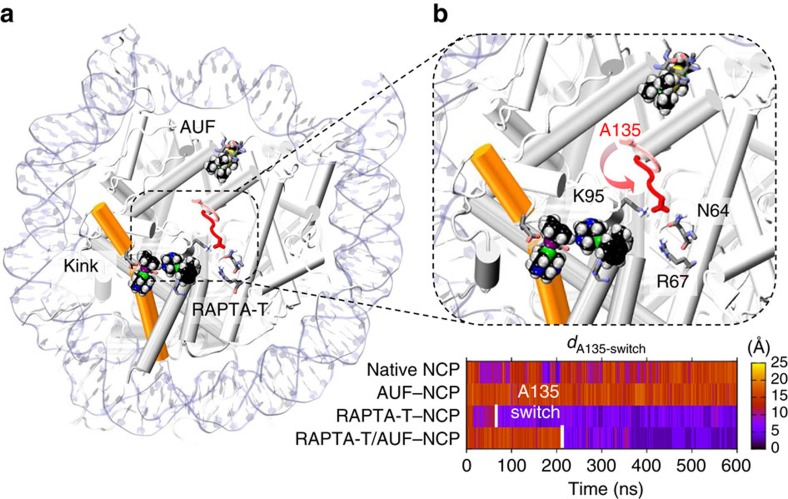
Conformational changes induced by RAPTA-T adducts.(a) Snapshot from MD simulations of the RAPTA-T/AUF–NCP system, showing a kink within the long α-helix of H2A induced by the presence of RAPTA-T adducts. The histone proteins (grey) are shown as cartoon, highlighting the kinked H2A α-helix in orange. The DNA is represented as pale blue ribbons. RAPTA-T and AUF (black) are shown in space-filling representation. (b) Close view of the nucleosome core, showing the conformational change involving the H3 C-terminus (A135), which occurs in the presence of RAPTA-T adducts and culminates in the H-bonding of A135 with H2A K95 and H4 N64. An arrow indicates the conformational change of H3 A135, which is shown as sticks in its initial (pink) and final (red) configurations. The bottom graph reports the time evolution along MD of the simulated systems for the distance (dA135-switch) between the Cα atom of H3 A135 and the centre of mass (COM) of the H4 N64 and H4 R67 residues, colour-coded according to the scale on the right. The A135 switch occurs after ∼80 ns (RAPTA-T/–NCP) and ∼220 ns (RAPTA-T/AUF–NCP) and is indicated with a white bar.